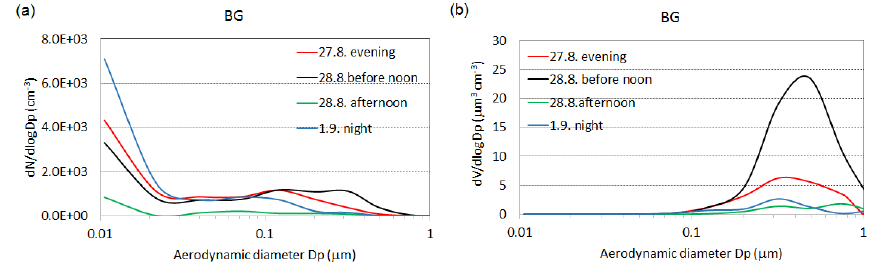
Figure 6. Number (a) and volume (b) size distributions of background particles.